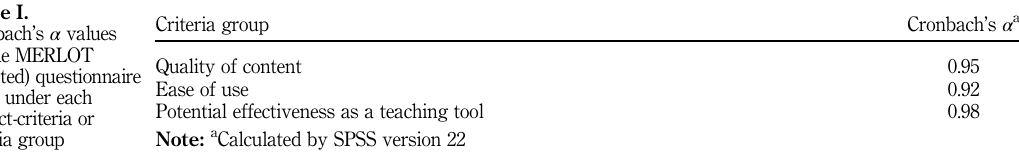
Table I. Cronbach ’ s α values for the MERLOT (adapted) questionnaire items under each subject-criteria or criteria